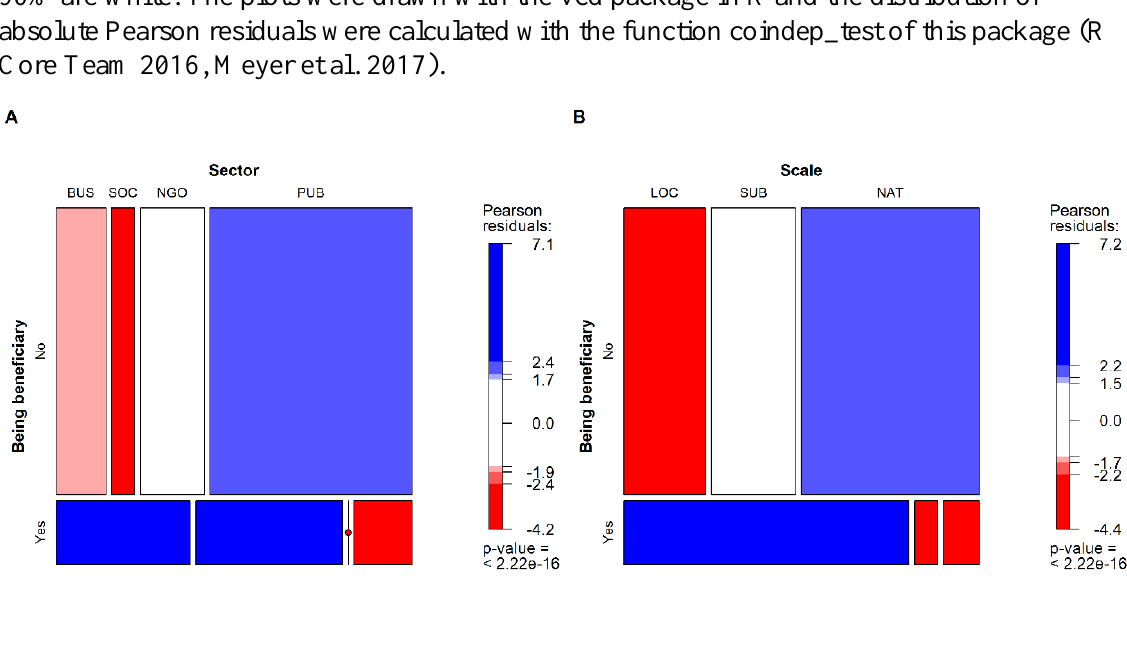
Figure A5.1. Mosaic plots of the frequency of being/not being beneficiary of ES for different groups of stakeholders. Each box is associated with a binary variable in left list (Yes beneficiary, and No beneficiary) and stakeholders groups in top list (Sector in panel A - BUS=Business, SOC=Civil Society, NGO=Non-Governmental Organizations, PUB=Public Sector - and scale of influence in panel B - LOC=Local, SUB=Sub-national, NAT=National and International). The height of a box is proportional to the number of observations for being/not being beneficiary of ES. The width of a box is proportional to the number of stakeholders in each